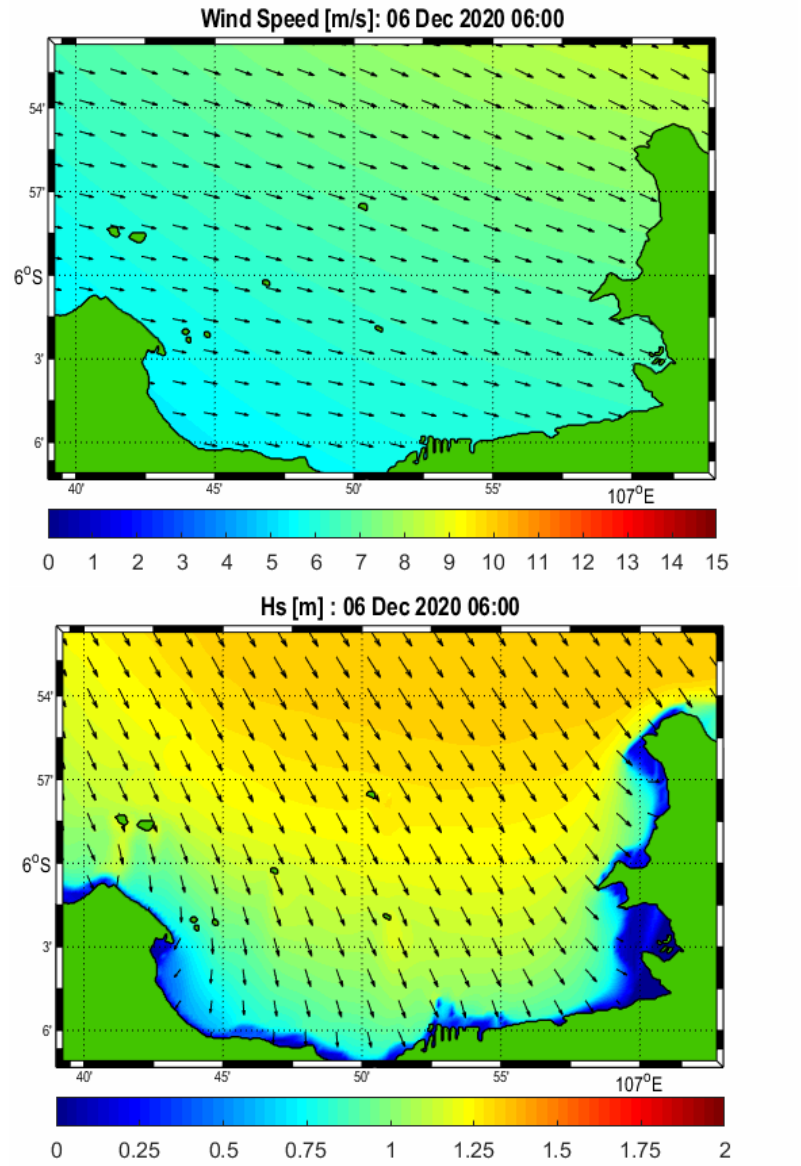
Figure 6. Similar to Figure 4 for